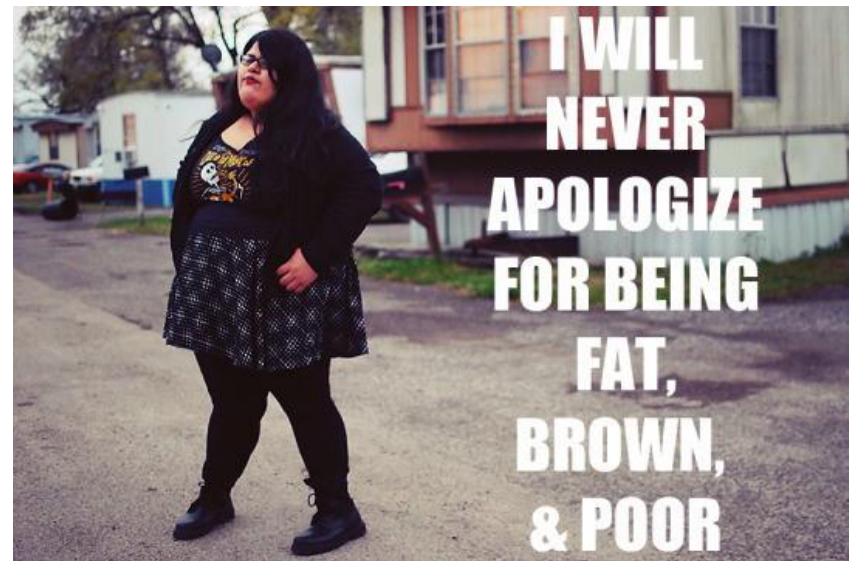
Figure 3. Some of my intersectionality makes up the visual frame of who I am and I will never apologize for this. To all my fat, brown, poor people out there, I feel you, I love you. It can be so fkn hard to navigate in this racist, colorist, classist, sizeist society and we’re some tough people who keep going but we have power. ~Marisole (Permission granted for reproduction).